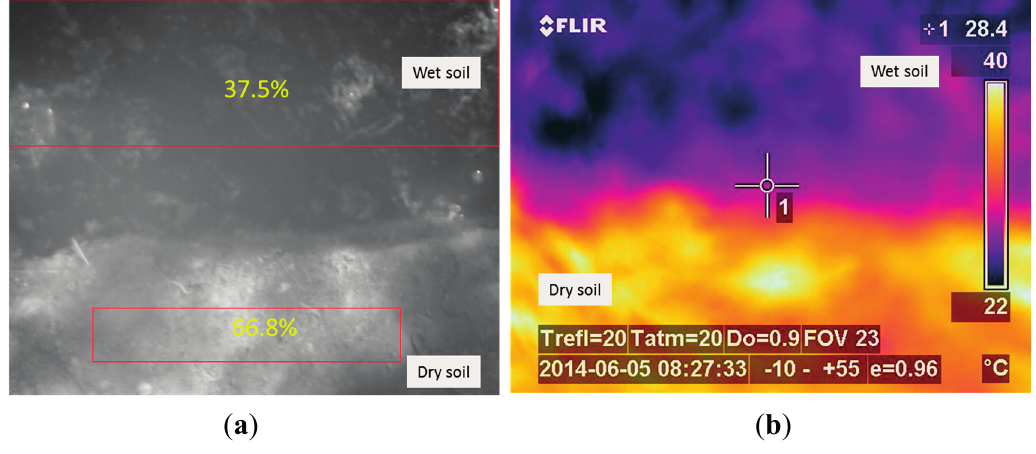
Figure 7. ( a ) Normalised SWIR image; ( b ) LWIR thermal image.